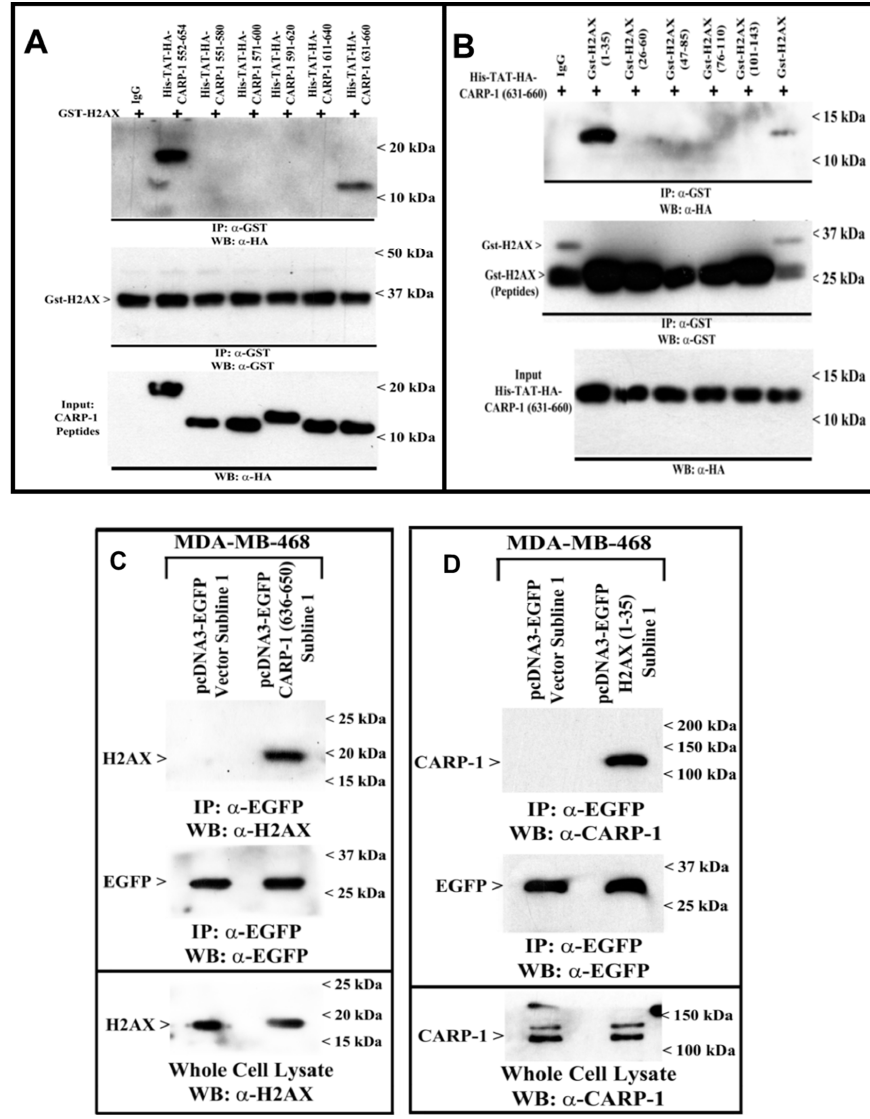
Figure 5. Fine Mapping of H2AX/CARP-1 interacting epitopes. The Gst-tagged H2AX protein, and various Gst-tagged H2AX peptides and His-TAT-HA-tagged CARP-1 peptides were purified